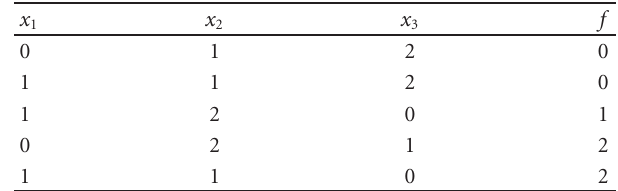
Table 1: Table for f : Z 3 3 → Z 3